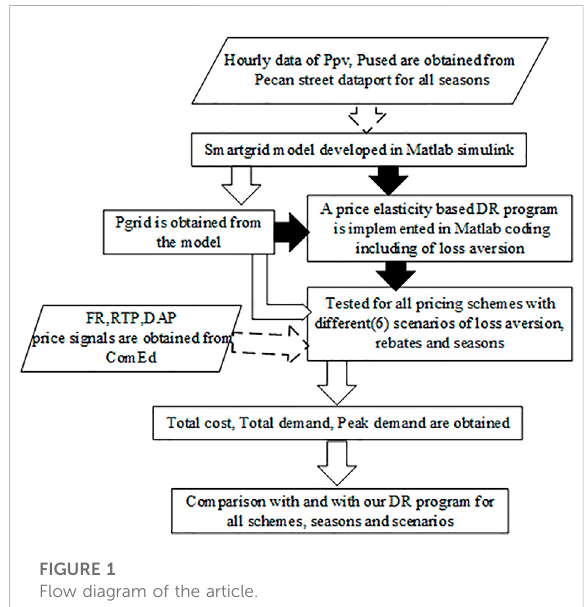
FIGURE 1 Flow diagram of the